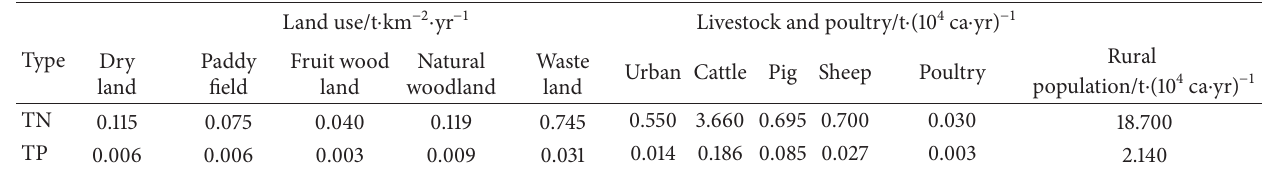
Table 1: The classification and value of export coefficient in study